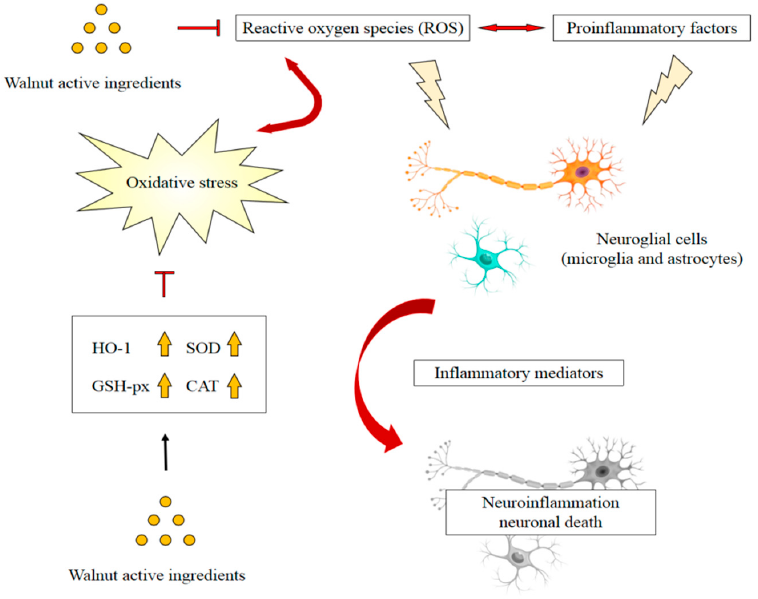
Figure 1. Possible mechanism of walnut active ingredients attenuating neuroinflammation by re- ducing oxidative stress. Adapted from